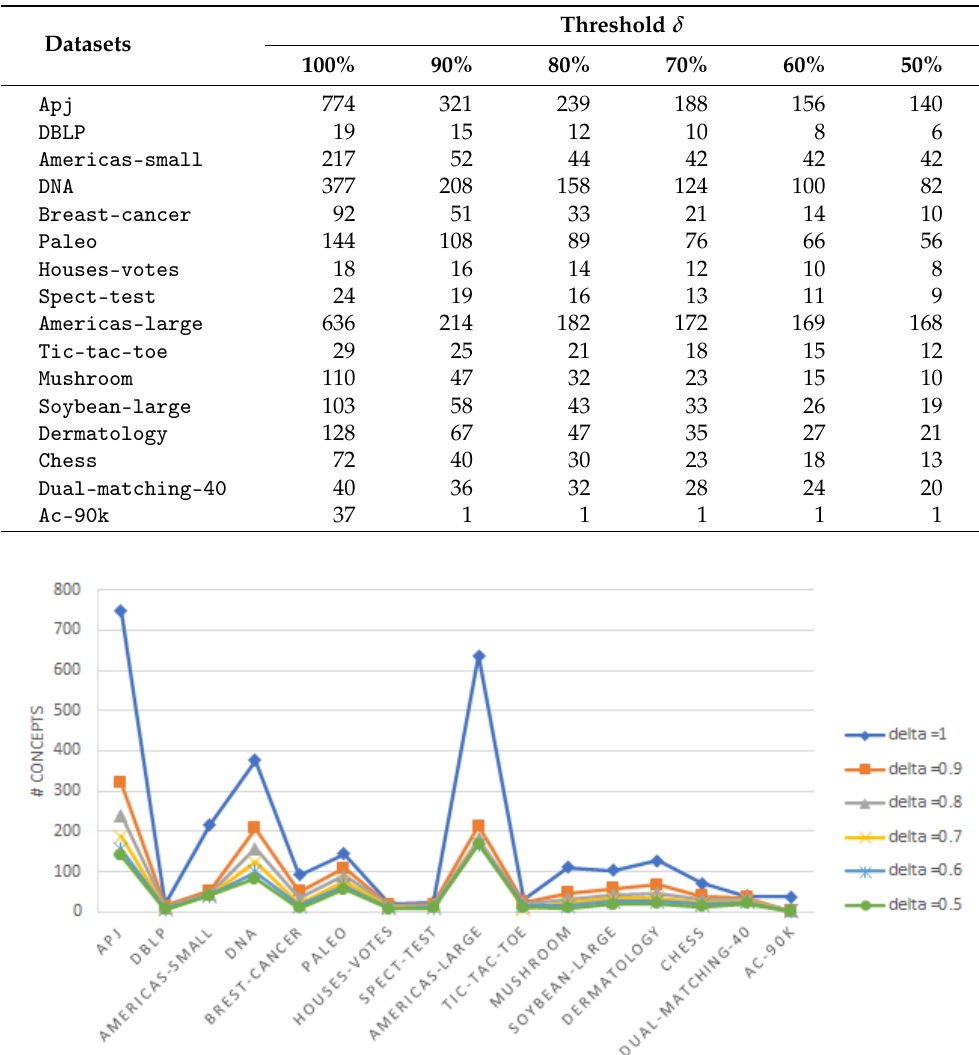
Figure 2. The impact of the variation of δ on the number of concepts generated by the C ONCISE